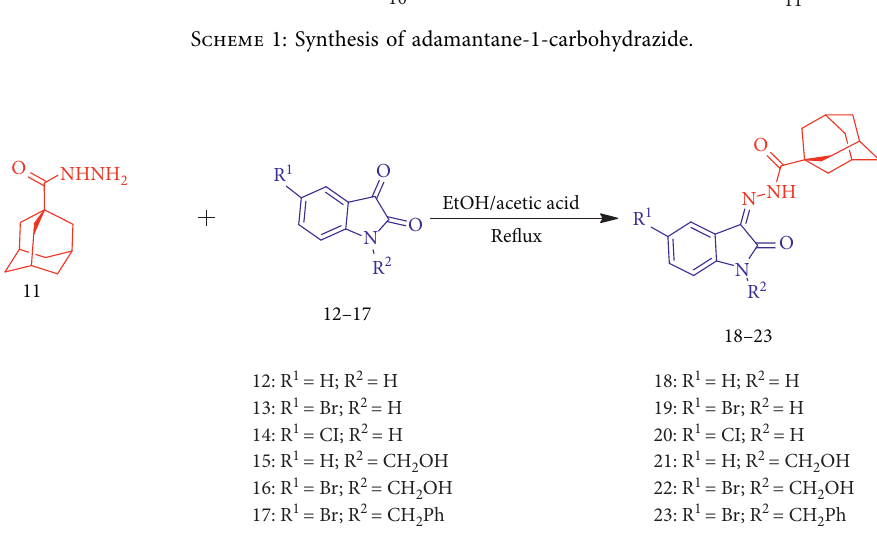
Scheme 2: Synthesis of target hybrid molecules Table 1: Drug-like properties and docking energies of compounds 18–23.